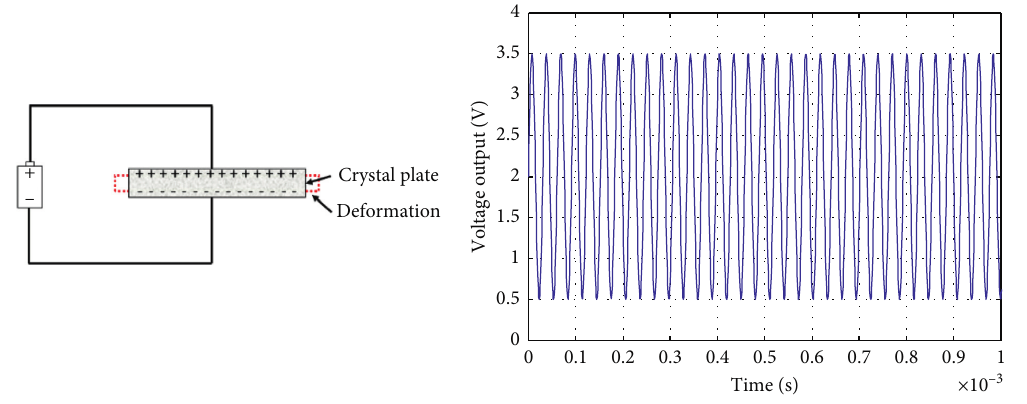
Figure 2: Piezoelectric resonance of the crystal plate.